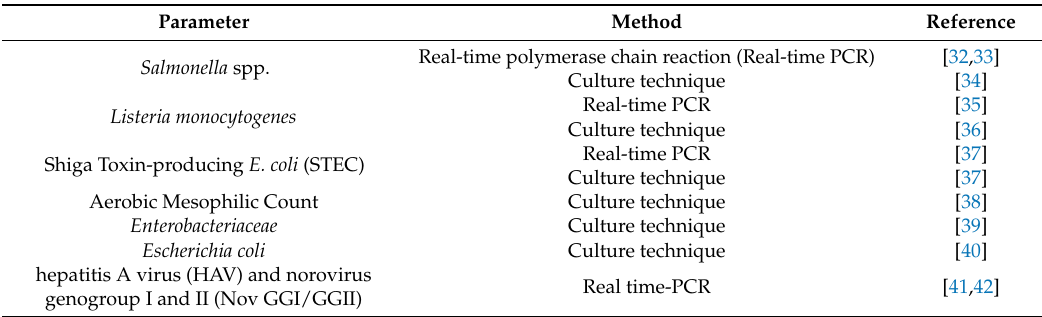
Table 1. Methods used for the microbiological